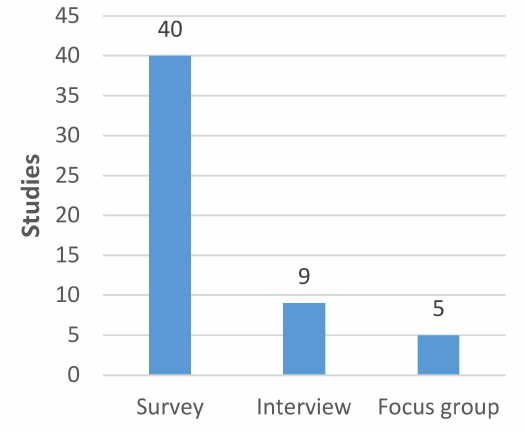
Figure 2. Study methods.